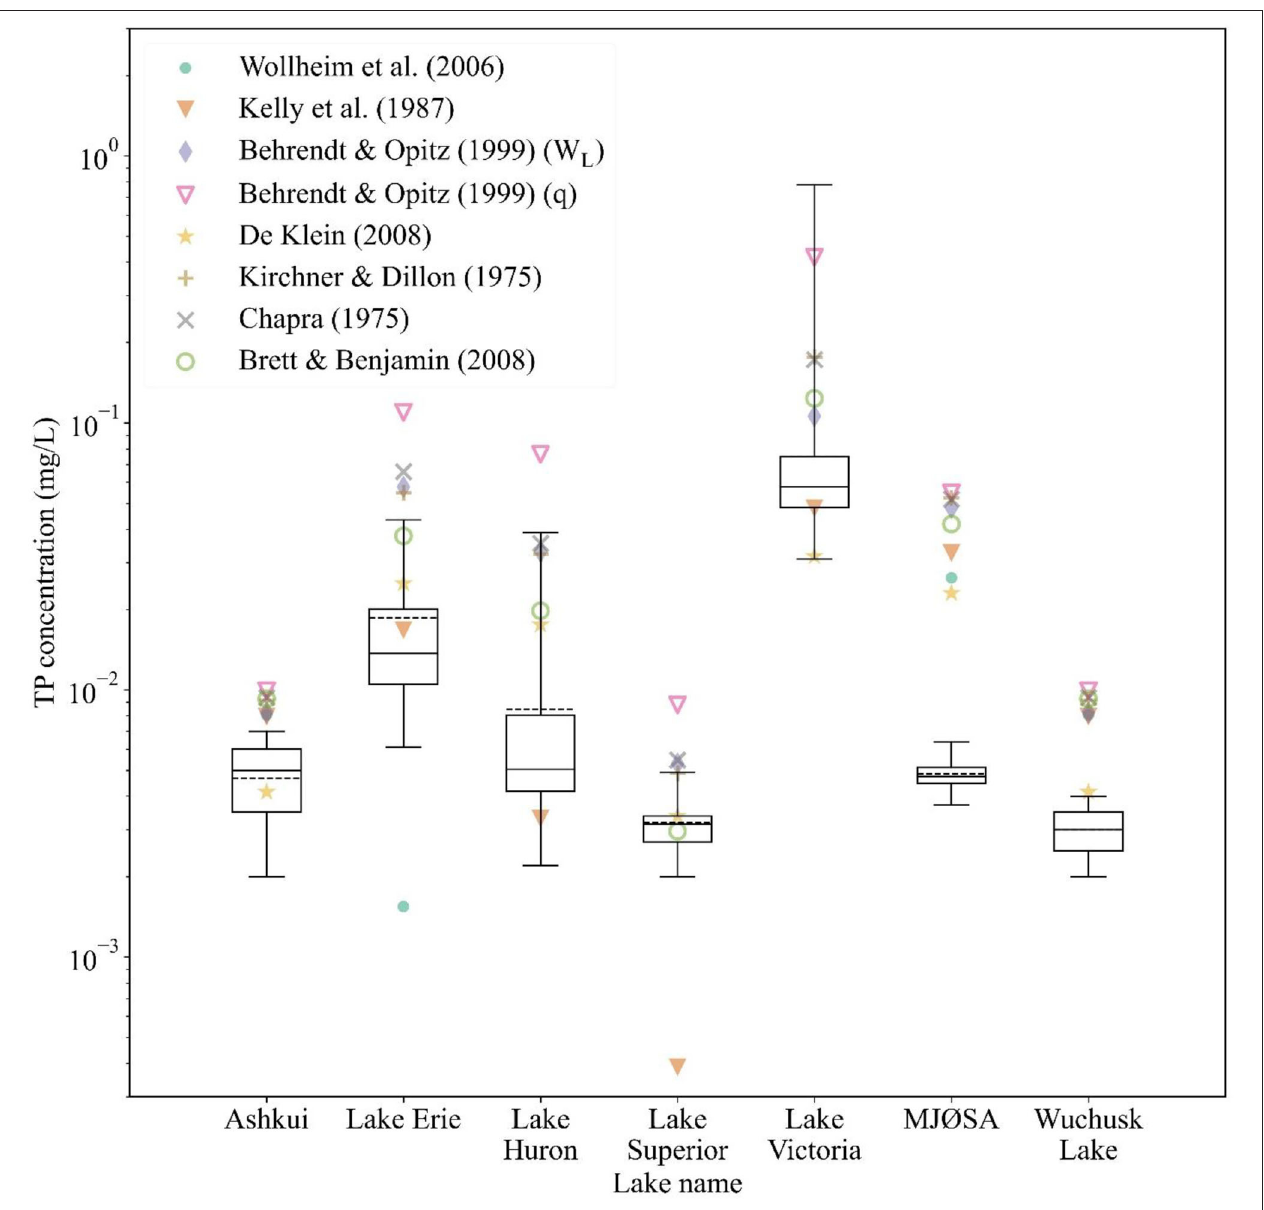
FIGURE 4 | Simulated TP concentration of lakes compared with observed values. The boxplot shows the range of observed TP concentrations of each lake: the dark solid lines in the boxes are the median value of observations; the dark dash lines are the average of observations; the upper and lower borders of the boxes indicate 75th percentile and 25th percentile of observations; the whiskers denote upper and lower extremes of observations. IMAGE-GNM simulates lake concentration at the outlet cell of the lake, providing one value (average concentration) for each lake. Note that Wollheim et al.’s (2008) simulation of Lake Huron, Lake Superior, and Lake Victoria is not shown in the log-scaled figure, as it predicted an extremely low concentration ( < 0.0001 mg/L) for these lakes.